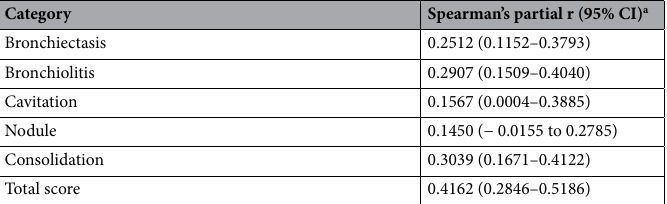
Table 5. Partial correlation coefficient for CA19-9 and CT score for NTM-PD. CA carbohydrate antigen, CT computed tomography, NTM-PD nontuberculous mycobacterial pulmonary disease, CI confidence interval, BMI body mass index. a The controlled variables included age, sex and